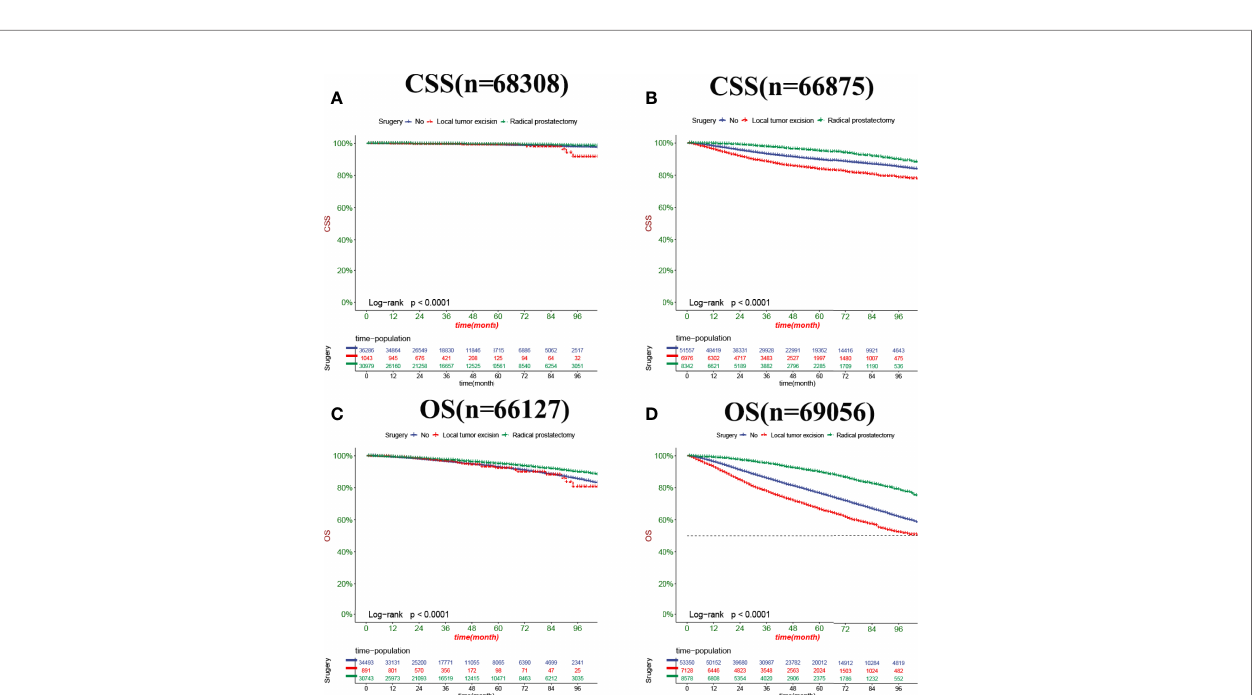
FIGURE 6 | Kaplan-Meier curves of patients in the low-risk and high-risk groups. The K-M curve showed that the CSS rate of the patients in the high-risk group was signi fi cantly lower than that in the low-risk group both in the training set (A) and validation set (B) . The K-M curve showed that the OS rate of the patients in the high-risk group was signi fi cantly lower than that in the low-risk group both in the training set (C) and validation set (D) .